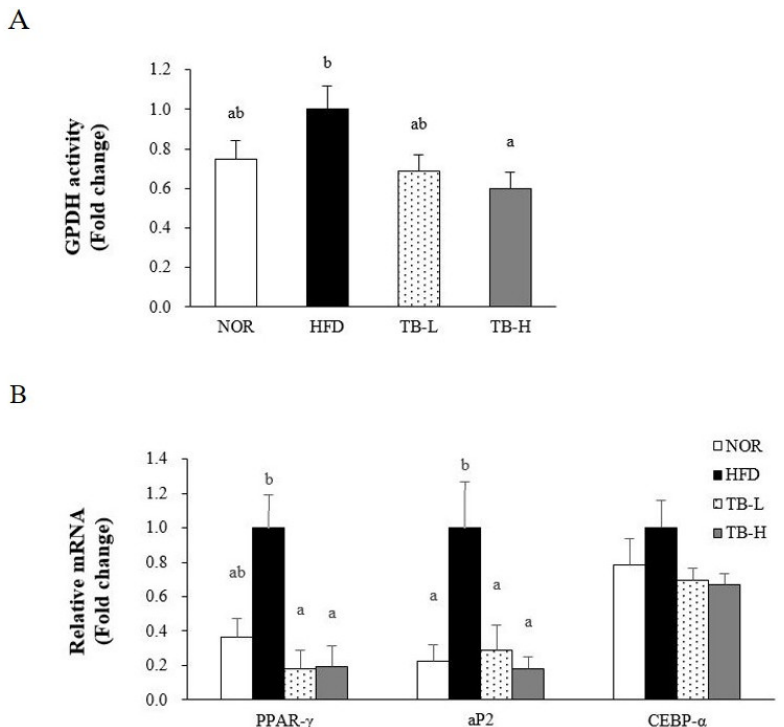
Figure 2. Effects of tartary buckwheat extract on adipogenesis. ( A ) Glycerol-3-phosphate dehydrogenase (GPDH) activity. ( B ) Gene expression level of PPAR-γ, ap2, and C/EBP-α. The mRNA level was normalized to GAPDH. Data are expressed as mean ± SEM ( n = 8). Values with different letters are significantly different at p < 0.05. NOR: normal diet; HFD: 45% high-fat diet; TB-L: HFD + 0.5% TB; TB-H: HFD + 1.0%